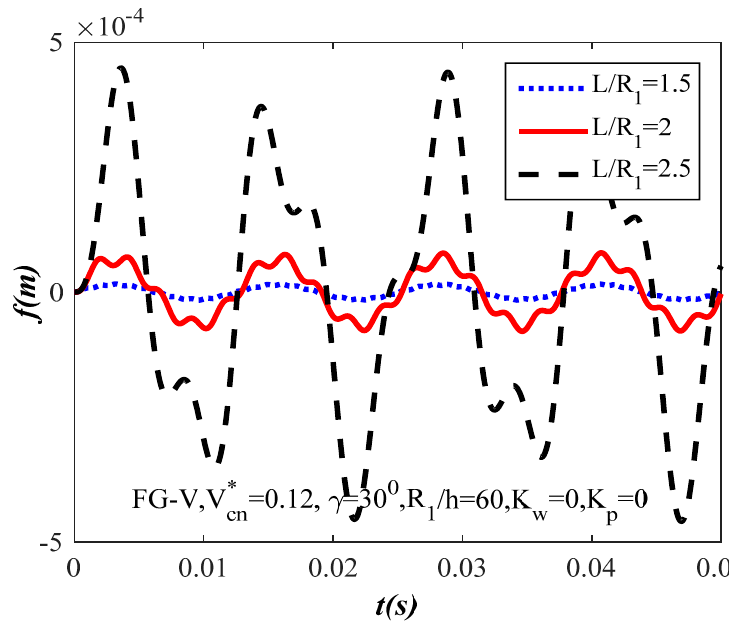
/ L R on the dynamic response of the FG-CNTRC truncated conical shells. Figure 6. Effect of ratio L / R 1 1 on the dynamic response of the FG-CNTRC truncated conical shells.